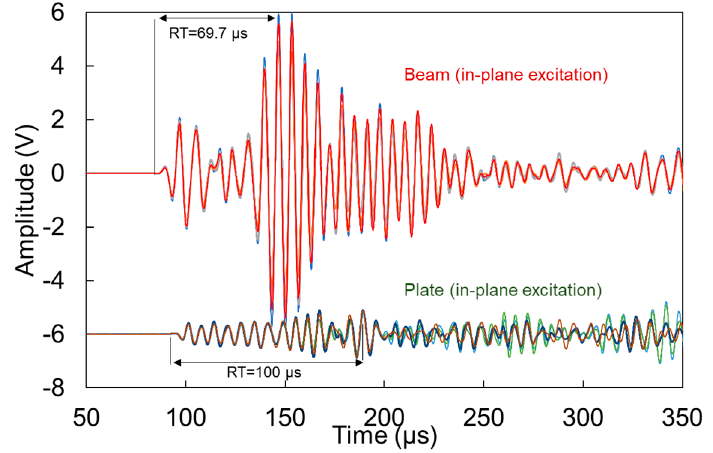
Figure 6. Waveforms received after pencil lead excitation on the side of the specimens (in-plane excitation) for beam and plate geometries.